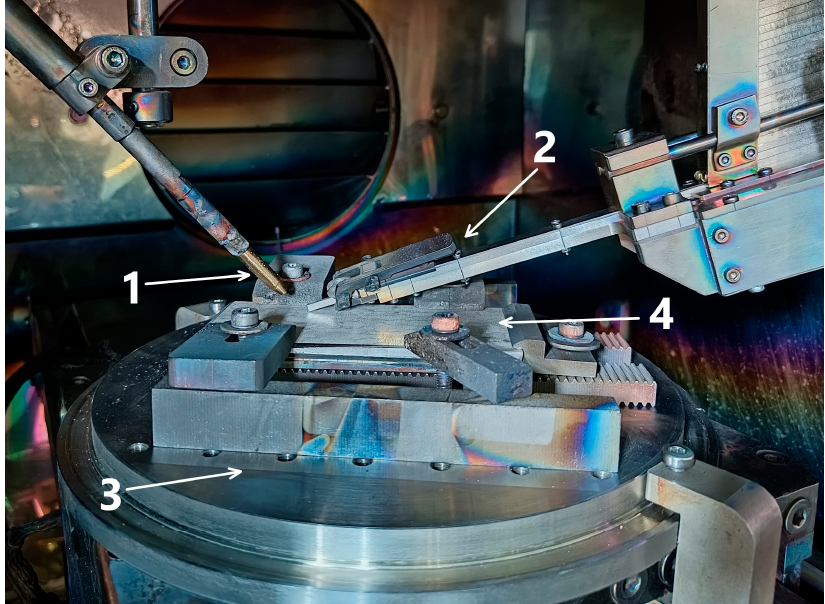
Figure 1. Configuration of the camera of the EBAM machine for printing by a combined method with wire and bar feeding of the material: (1) wire feeder, (2) bar feeder, (3) cooled table, (4) steel substrate.